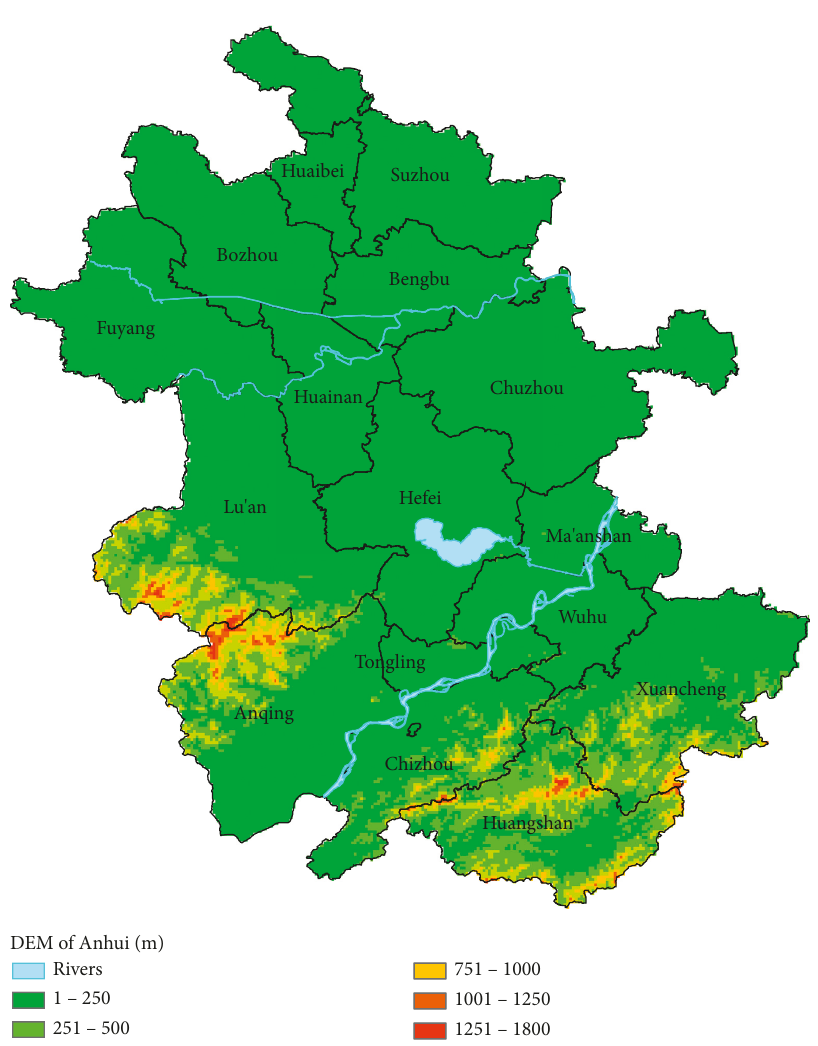
Figure 2: Digital elevation model (DEM) of Anhui (m).